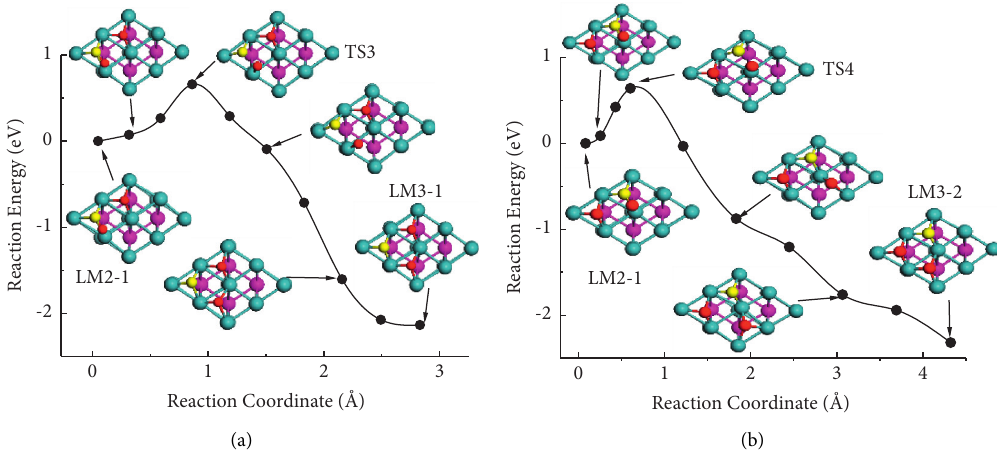
Figure 8: Potential energy surface of NO 2 molecule in the second step deoxidation process of Mo Path 1: As shown in Figure 7(a), the most possible pathway of the first deoxidation process of NO on Mo 2 (110) surface starts from LM1-2 to LM2-1 via the transition states TS1 and TS1 ′ . The heat release in the whole process is up to 2.79 eV. During this process, it needs to cross two transition states with energy barriers of 0.11 eV and 0.50 eV, respectively. The activated N–O bond length changes from 1.372 ˚A in the initial state to 1.419 ˚A in TS1, then extend to 2.709 ˚A in TS1 ′ and finally to be 2.741 ˚A in final state LM2-1. The bond angle of O–N–O changes from 113.7 ° in the initial state to 110.39 ° in TS1. The activated oxygen atom gradually crosses the short bridge position and finally reaches the hollow position. Path 3: Figure 8(a) is the potential energy surface of the